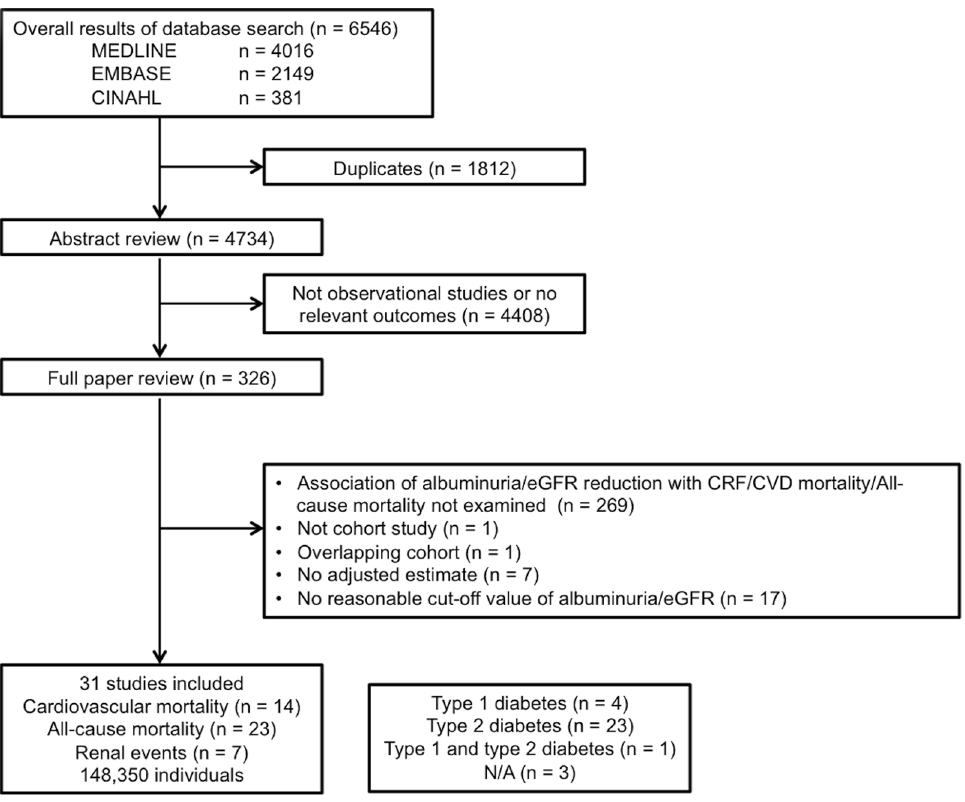
Figure 1. Process for identification of eligible studies Abbreviation: N/A, not available.